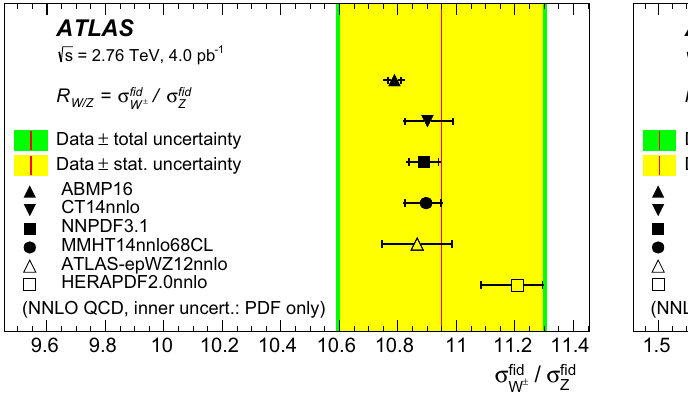
sets. The inner shaded band corresponds to statistical uncertainty while the outer band shows statistical and systematic uncertainties added in quadrature. The theory predictions are given with the corresponding PDF (total) uncertainty shown by inner (outer) error